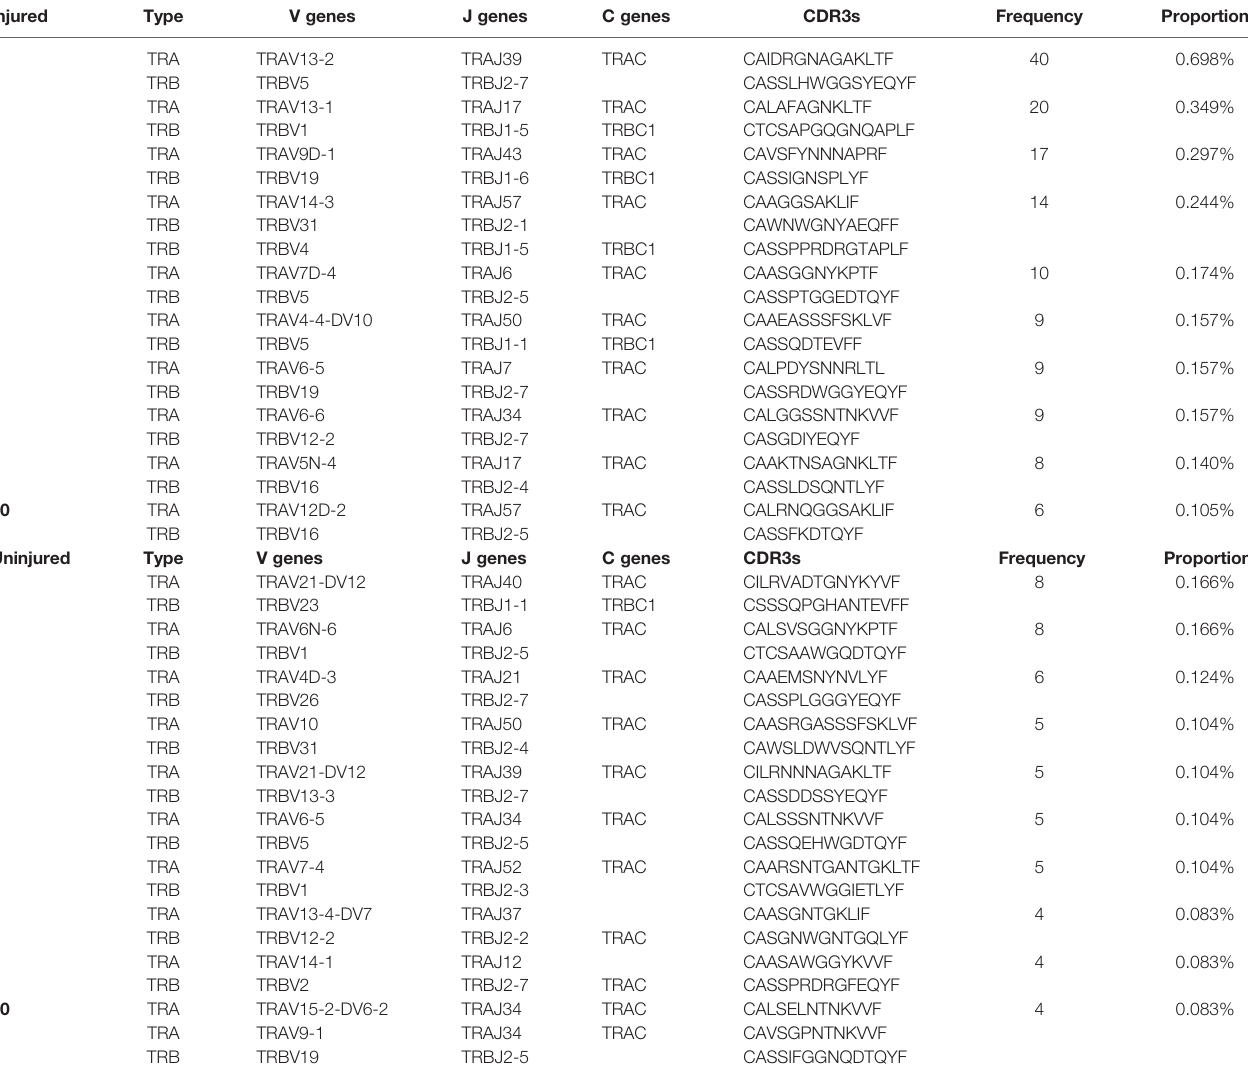
TABLE 1 | Top 10 TCR a / b paired clonotypes in Tregs from injured and uninjured mice.